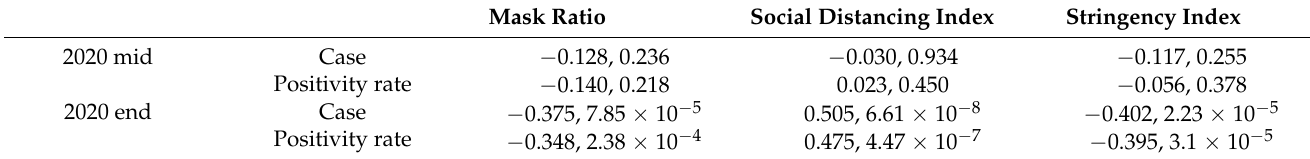
Table 3. Spearman’s simple correlations between percentage of influenza cases compared to baseline cases (upper, main analyses)/percentage of positivity rates during the pandemic compared to baseline positivity rates (lower) and each control measure. Left: correlation coefficient (rho), Right: ( p values). Mask Ratio Social Distancing